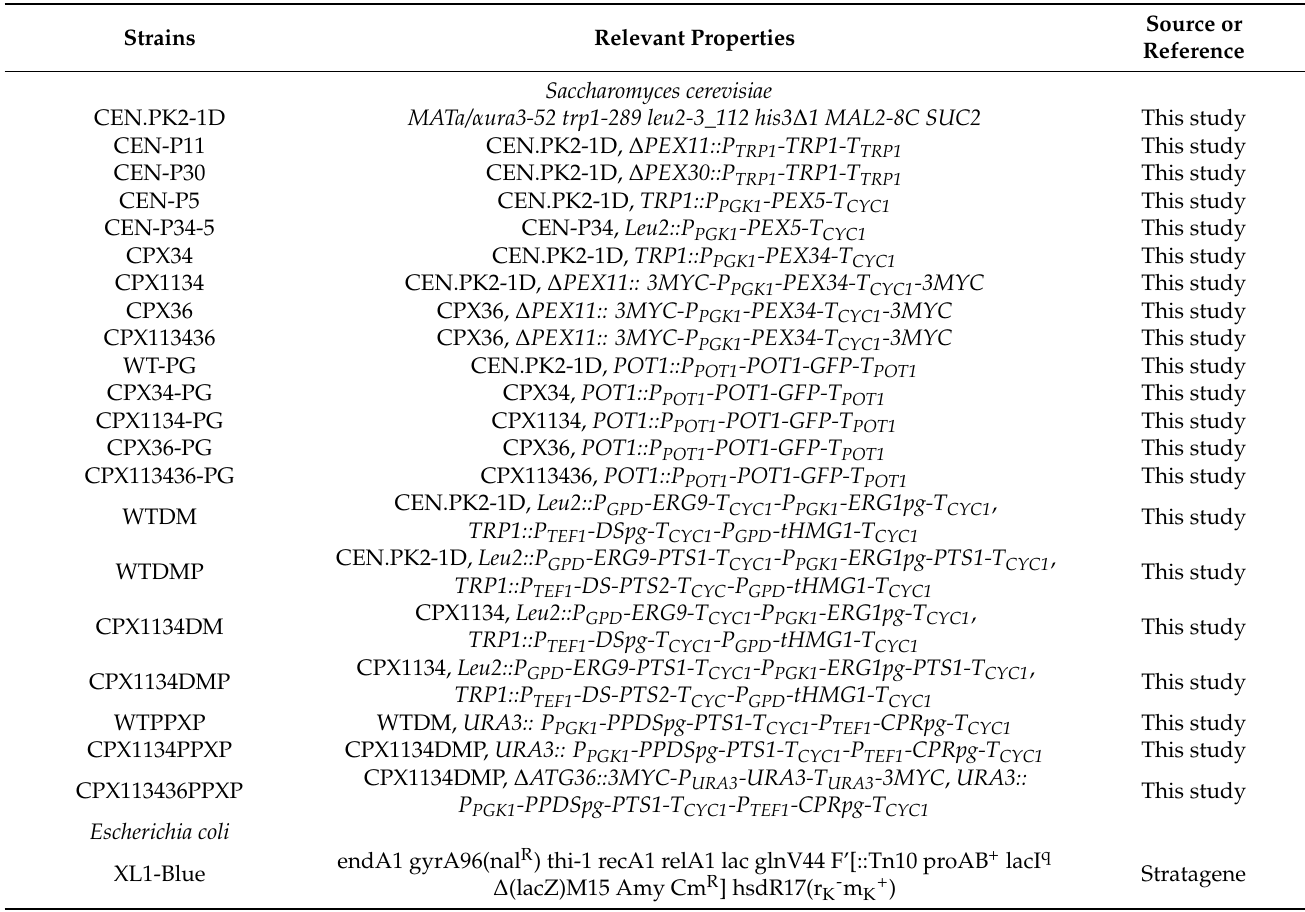
Table 1. Strains used in this study.